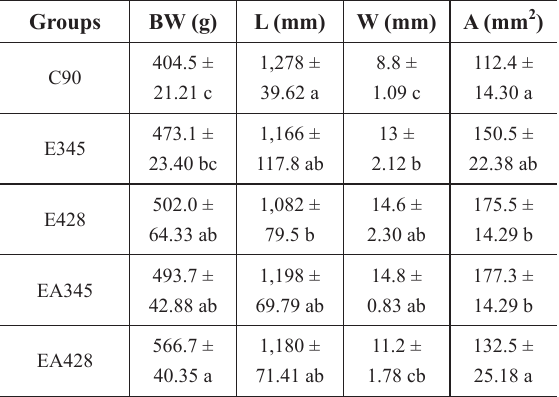
Body weight (BW, g), length (L, mm), width (W, mm) and area (A, mm 2 ) of the small intestine of rats of different ages: C90 days, E345 days, E428 days, and with ascorbic acid supplementation: EA 345 and EA 428 days (n = 5). Data were expressed as mean ± standard